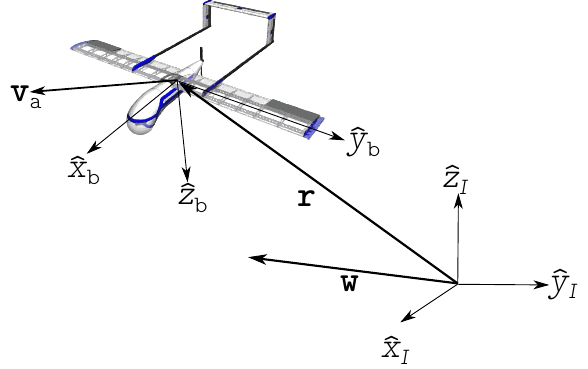
Figure 1. Reference frames utilized in the formulation of the identification of wind vector